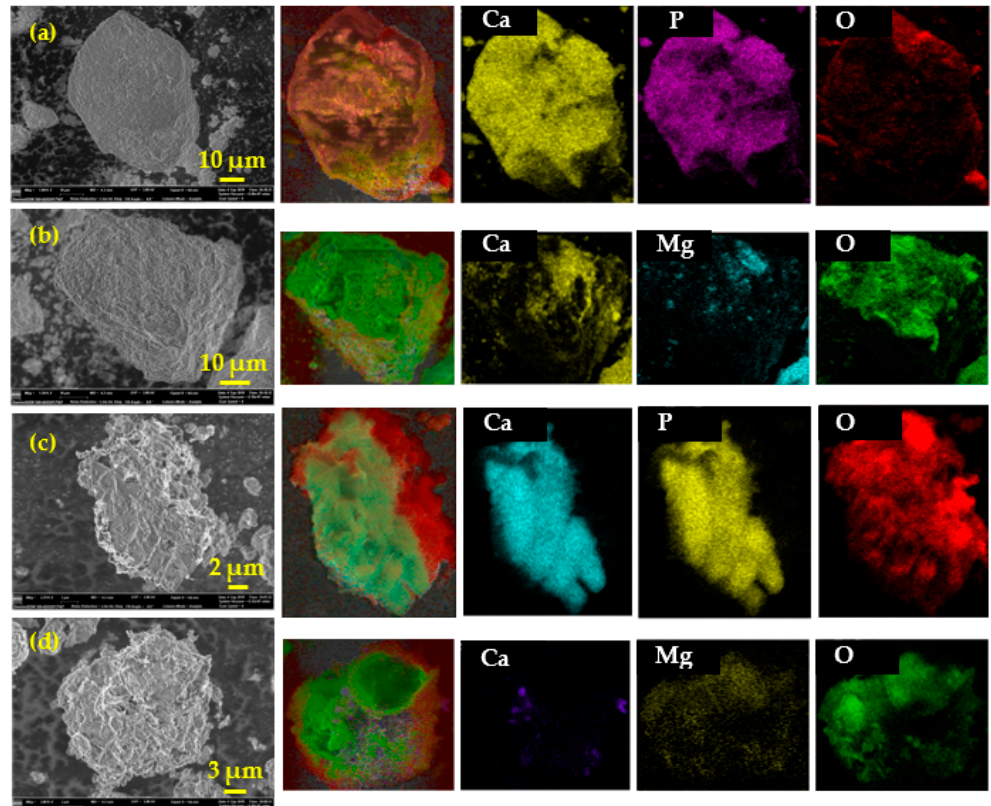
Figure 3. Leaching efficiency of REEs as a function of time at different phosphoric acid concentra- tion.